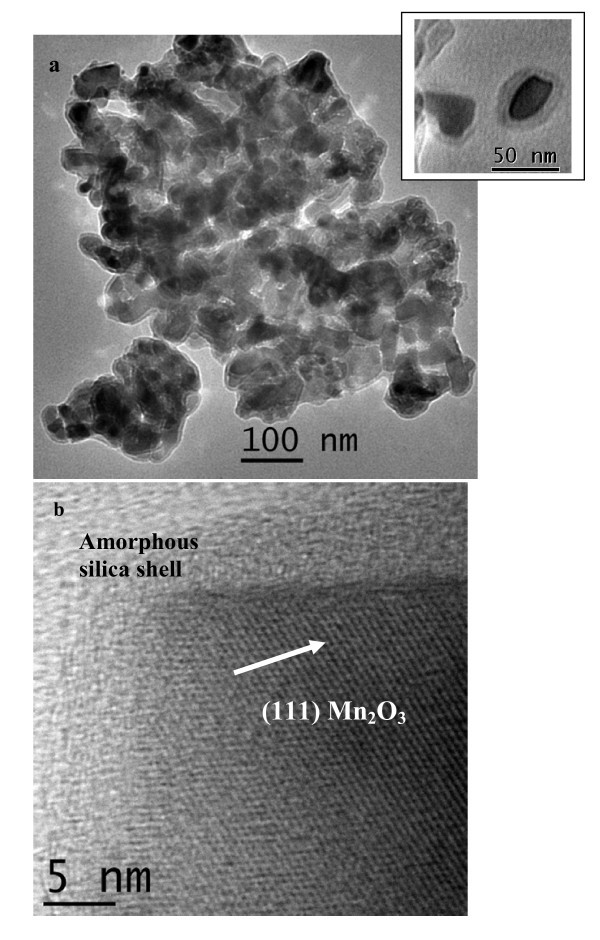
TEM and HRTEM image. (a) TEM and (b) HRTEM images of Mn2O3@SiO2 core-shell nanostructures.